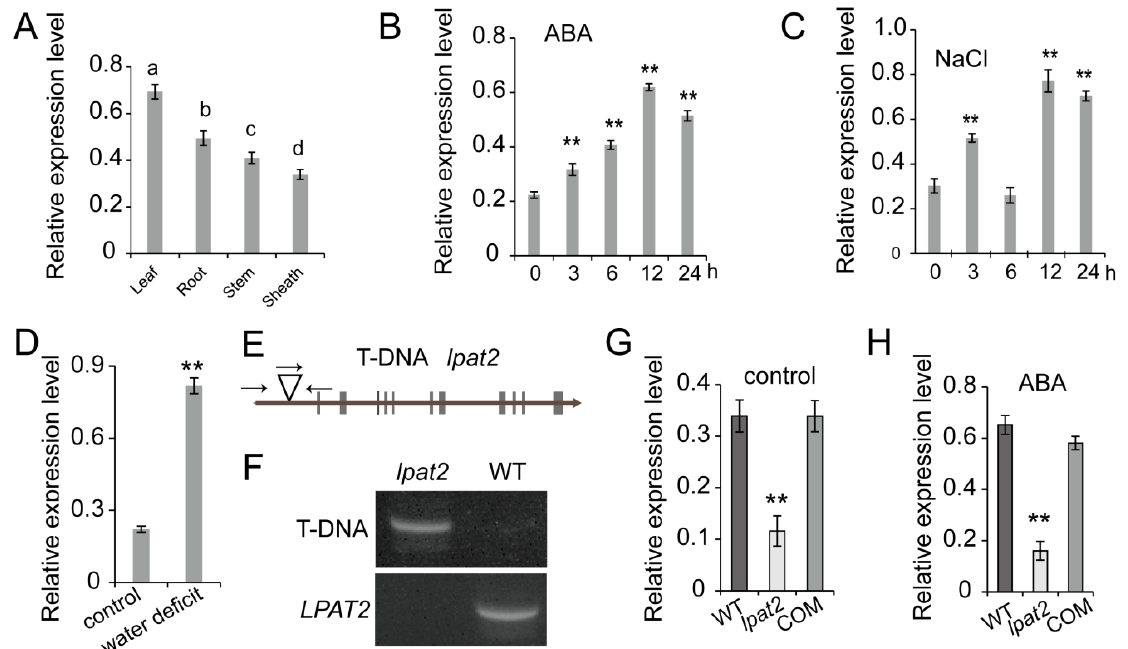
Figure 1. Rice LPAT2 expression pattern, the lpat2 mutant isolation, and genetic complementation. ( A ) The LPAT2 expression level in various tissues. Values are means ± SD ( n = 3). ( B – D ). The LPAT2 transcript level in leaves in response to ABA. The different letters indicate the significant difference at p < 0.05 based on the Duncan ’ s multiple ranges. ( B ), salt stress ( C ), and water deficit ( D ) treat- ments. Total RNA was extracted from leaves of two-week-old plants at different time points (0, 3, 6, 12, and 24 h) for 100 mM NaCl and 10- μM ABA treatments. For water deficit, the leaves were sampled from plants grown under well-watered conditions (control) or under water deficit (25 to 30% of soil water capacity) when watering were withheld for five days. Values are means ± SD ( n = 3). ( E ) The T-DNA insertion site in rice LPAT2 . The arrows indicate the locations of primers for T-DNA insertion by PCR. ( F ) The lpat2 mutant isolation by PCR. ( G , H ) The LPAT2 expression level in the lpat2 mutant, wild type (WT) and LPAT2 complementation (COM) plants under the control conditions ( G ) and ABA treatment ( H ). Data are means ± SD ( n = 3). Two-week-old plants were treated with 10 μM ABA for 12 h. The LPAT2 transcript level was determined by RT-qPCR by using β -Actin as an internal standard. ** indicates significant difference at p < 0.01 compared to WT plants based on Student’s t test.